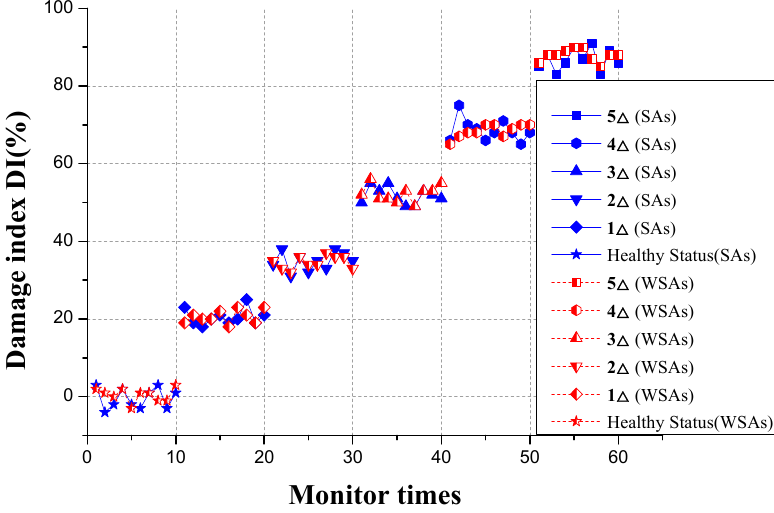
Figure 21. Damage index in different conditions.